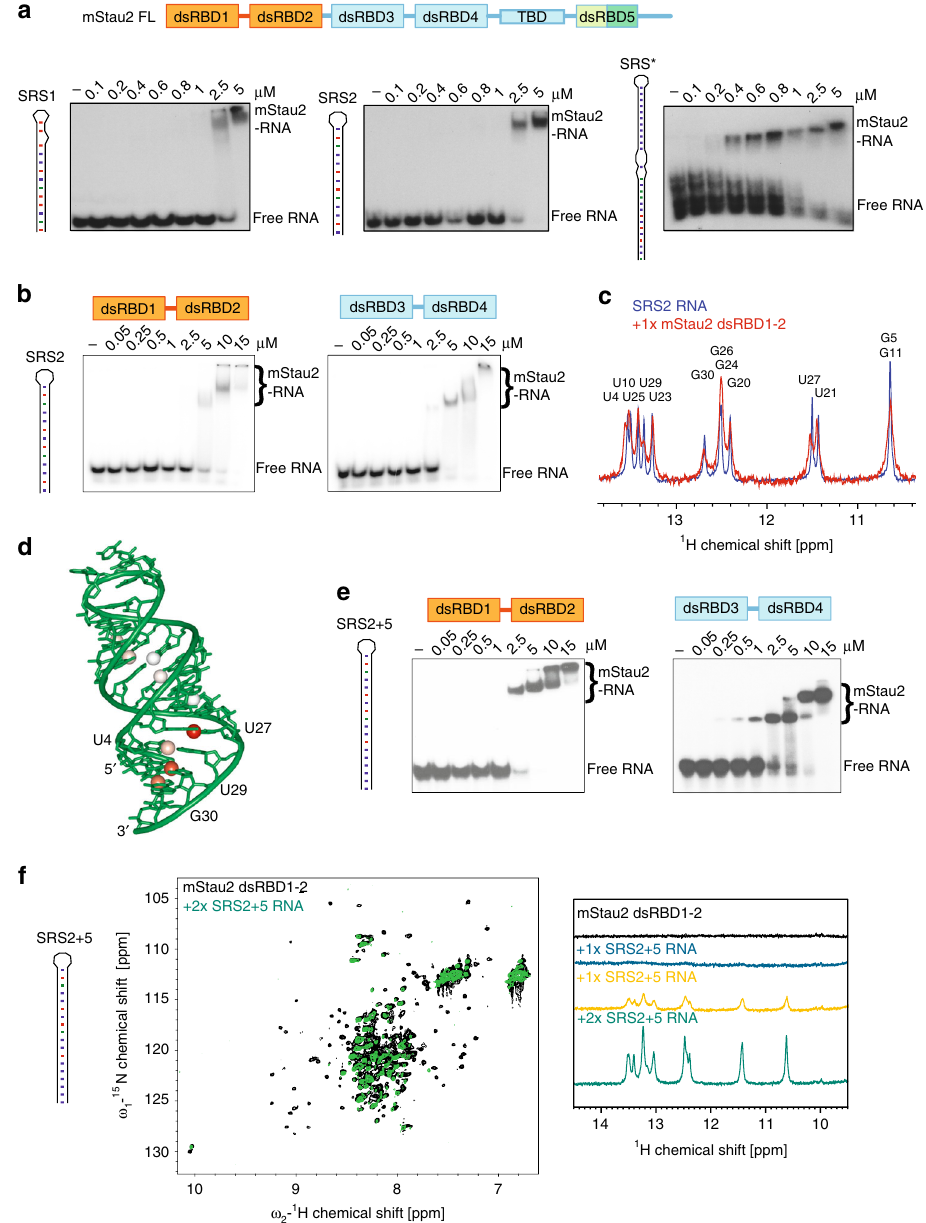
Fig. 1 The dsRBD1 – 2 tandem domain of mStau2 binds RNA. a EMSAs with full-length mStau2 (mStau2 FL) and different SRS RNAs from the 3 ′ UTR of the Rgs4 mRNA. b EMSAs with mStau2 tandem domains dsRBD1 – 2 or dsRBD3 – 4 and SRS2. c NMR titration experiments of mStau2 dsRBD1 – 2 with SRS2 RNA. d Crystal structure of SRS2 at 1.73 Å resolution. Iminos from c showing signi fi cant line broadening are indicated by colored (orange to red) spheres. e EMSAs with mStau2 tandem domains dsRBD 1 – 2 or dsRBD 3 – 4 and SRS2 RNA extended by fi ve basepairs (SRS2 + 5). f NMR titration experiments of mStau2 dsRBD 1 – 2 with SRS2 + 5 RNA. Left: overlay of 1 H, 15 N-HSQC spectra of dsRBD1 – 2 in absence and presence of 2x excess SRS2 + 5 RNA. Resonance shifts and line broadening of several signals are observed. Right: comparison of 1D imino traces of SRS2 + 5 RNA at different stoichiometric ratios with dsRBD 1 – 2. Strong line broadening of imino signals is observed in presence of protein. Source data are provided as a Source Data fi le